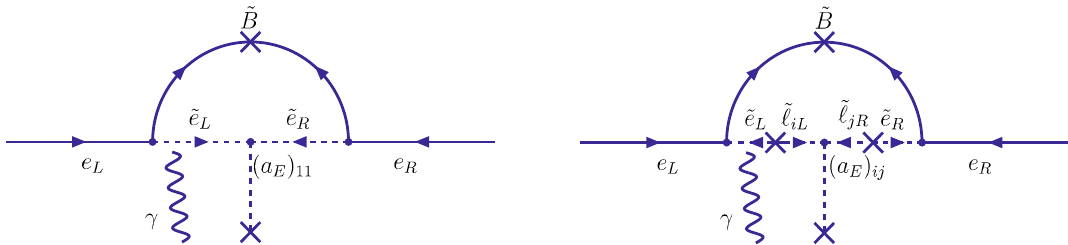
Fig. 4 Contributions to the electron EDM mediated by the bino, without flavor violation (left diagram) and with flavor violation (right diagram), respectively. The states (cid:17) are flavor eigenstates (cid:17) 1 = e , (cid:17) 2 = μ , (cid:17) 3 =